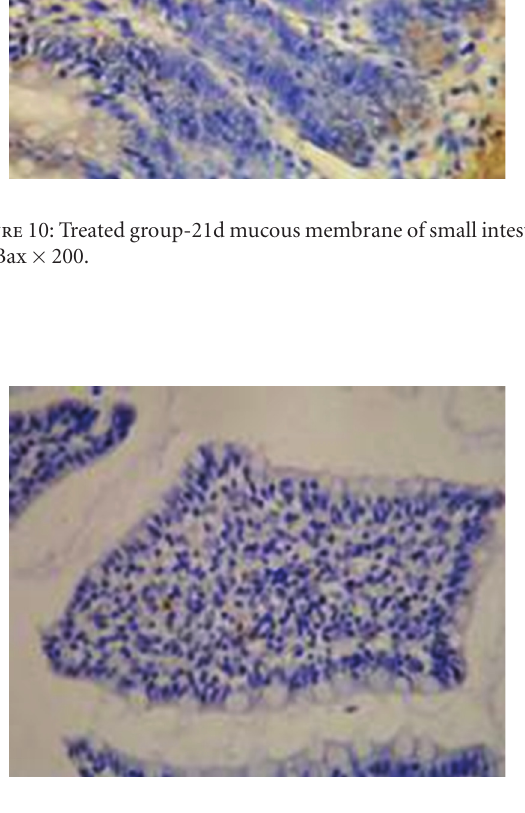
Figure 11: Treated group-21d a few apoptotic cells in mucous membrane of small intestine TUNEL ×